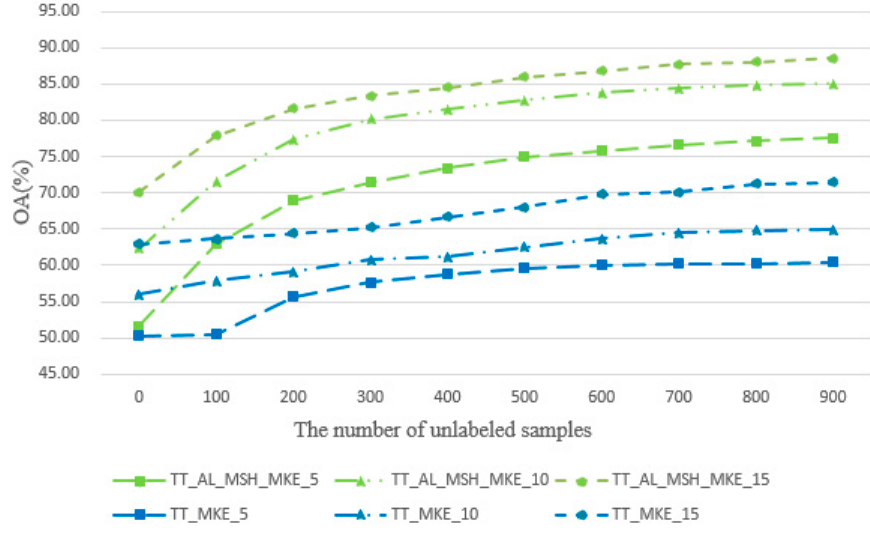
Figure 5. Overall classification accuracies obtained for the AVIRIS Indian Pines dataset using two different techniques by using 5, 10 and 15 labeled samples per class (estimated labels of unlabeled samples were used in all of the experiments).